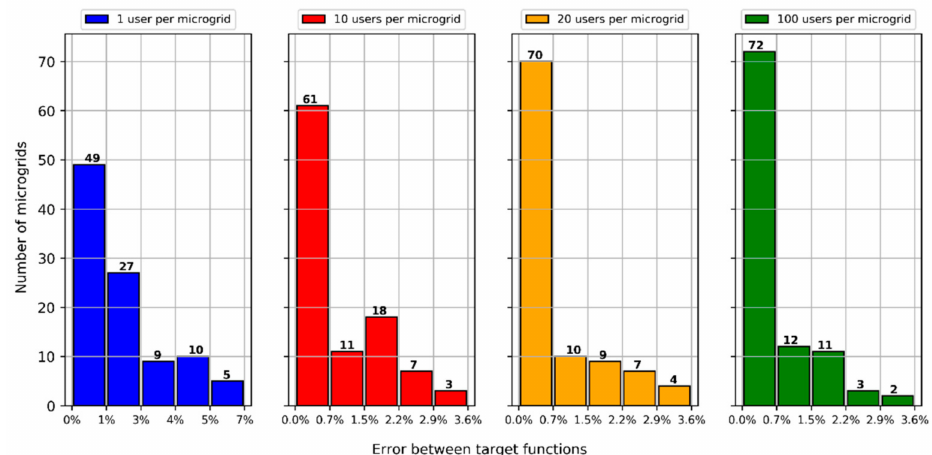
Figure 16. Percentage difference between cost functions of the deterministic and stochastic problems, by groups of microgrids (Case